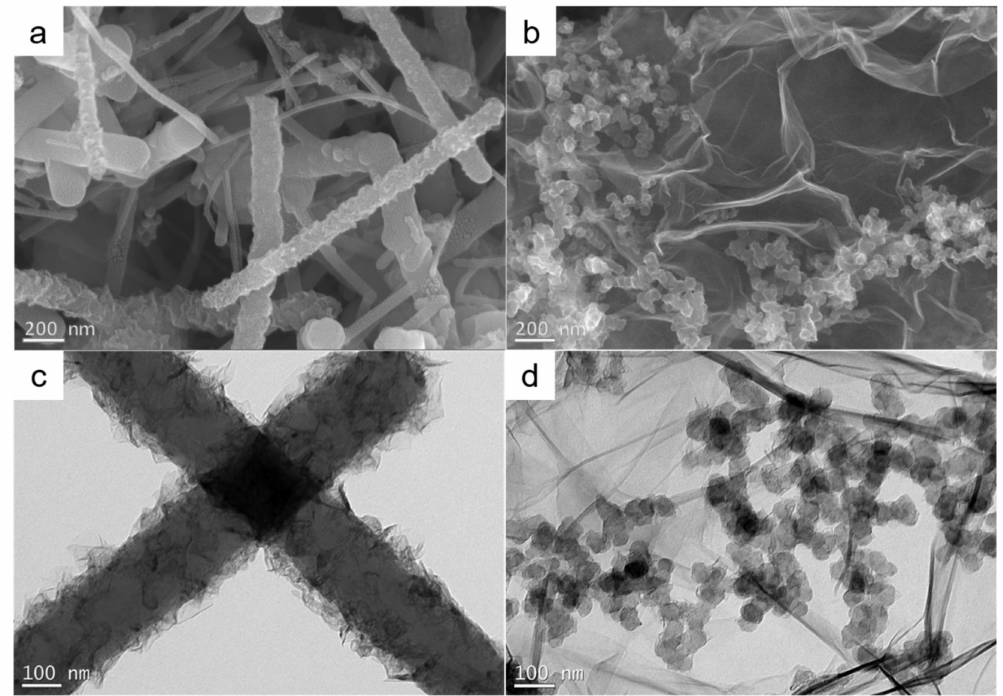
Figure 2. Microscopic morphology of CNT and CB/RGO ( a ) SEM image of CNT; ( b ) SEM image of CB/RGO; ( c ) TEM image of CNT; ( d ) TEM image of